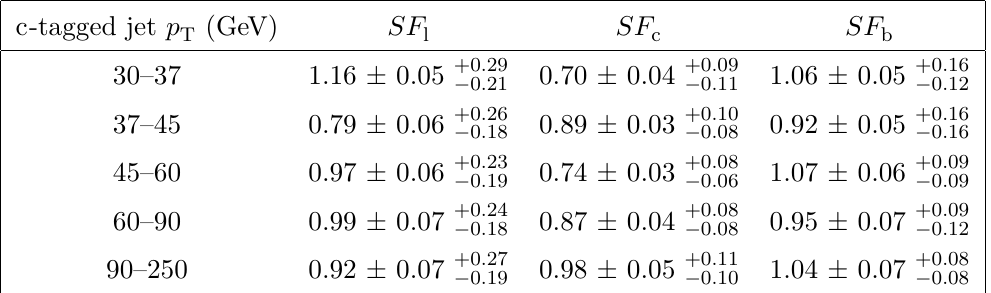
, Z + c jet SF , and Z + b jet SF scale factors measured in the l c b . The first uncertainty is the statistical uncertainty T